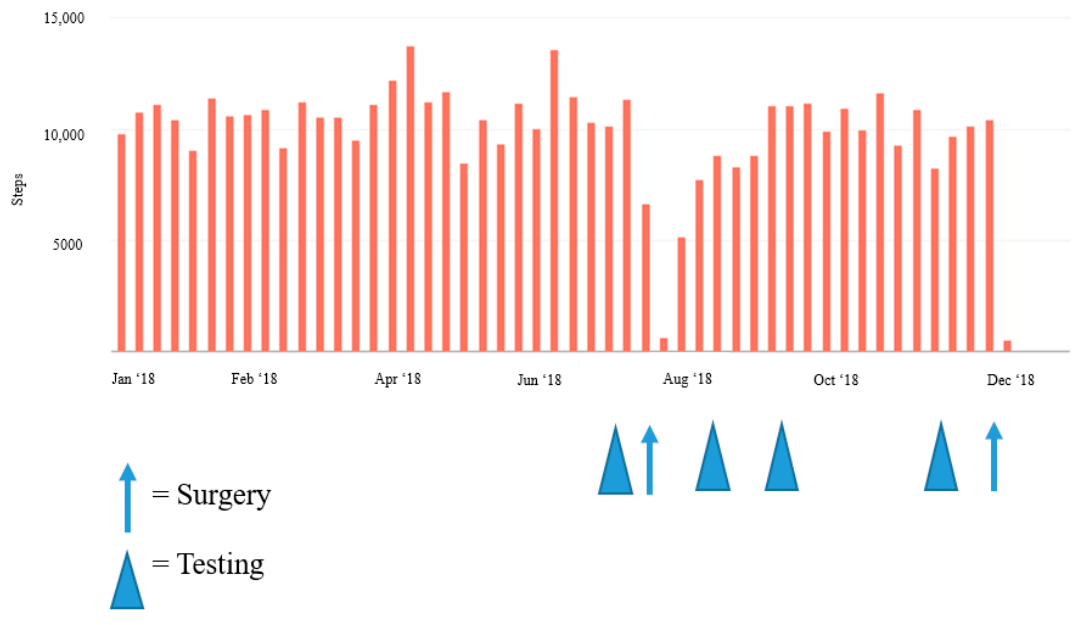
Figure 2. Weekly changes in step activity during 2018, pre- and post-operation.